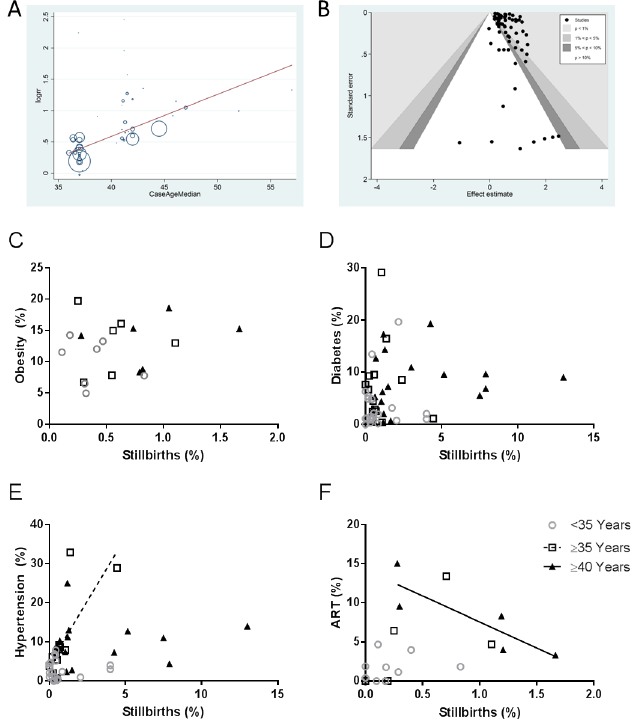
Fig 4. Stillbirth and co-morbidities. A) Meta-regression showed a linear association betweenstillbirth rates and maternalage (R 2 = 0.45) and B) contour enhancedfunnel plot representingno small study effects (Harbord’stest). Correlation betweenpopulationrates (% of total population)of maternalco-morbiditiesC) obesity, D) diabetes, E) hypertension and F) assisted reproductive therapieswith stillbirthfor mothers ages < 35, (cid:21) 35 and (cid:21) 40 years of age. Population rates of stillbirth were positivelycorrelatedwith rates of hypertension in (cid:21) 35 year old populationonly ( p = 0.002) and negatively correlatedwith ART in the (cid:21) 40 year old population only ( p = 0.017). Spearmanrank